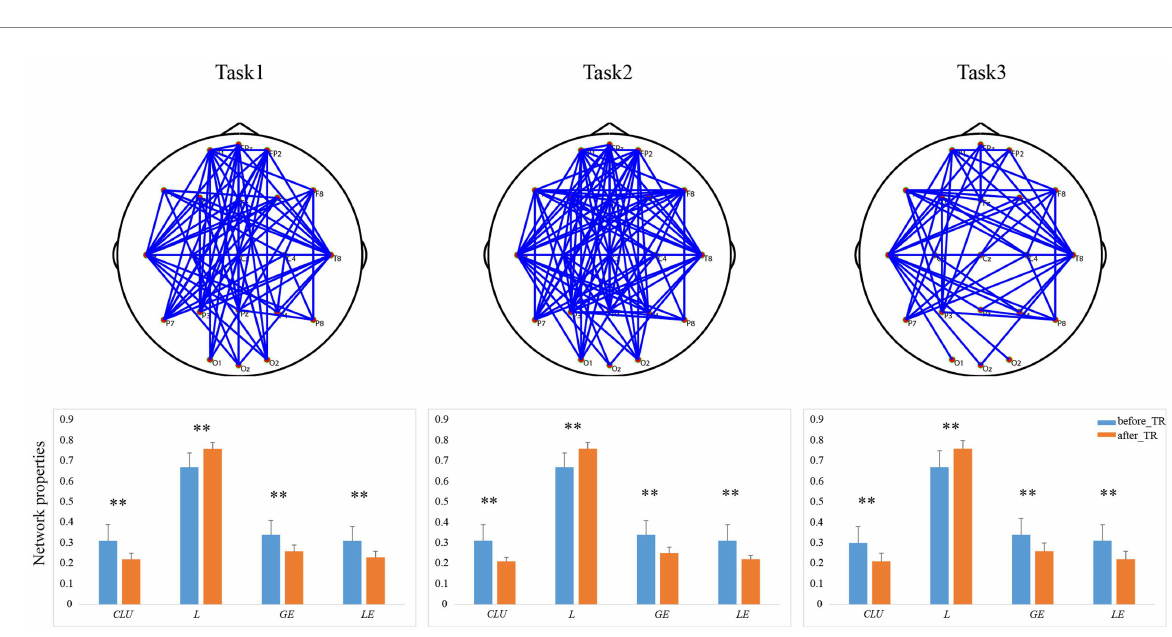
FIGURE 4 The first line is network topology differences between the before_TR group and the after_TR group in the cool executive tasks (Task 1: THT; Task 2: TMT-A; Task 3: TMT-B). The corresponding network properties in the three tasks were below the network topologies. ** indicates p < 0.01. The blue solid lines denote the stronger network edges ( p < 0.05, FDR corrected) of the before_TR group compared to those of the after_TR